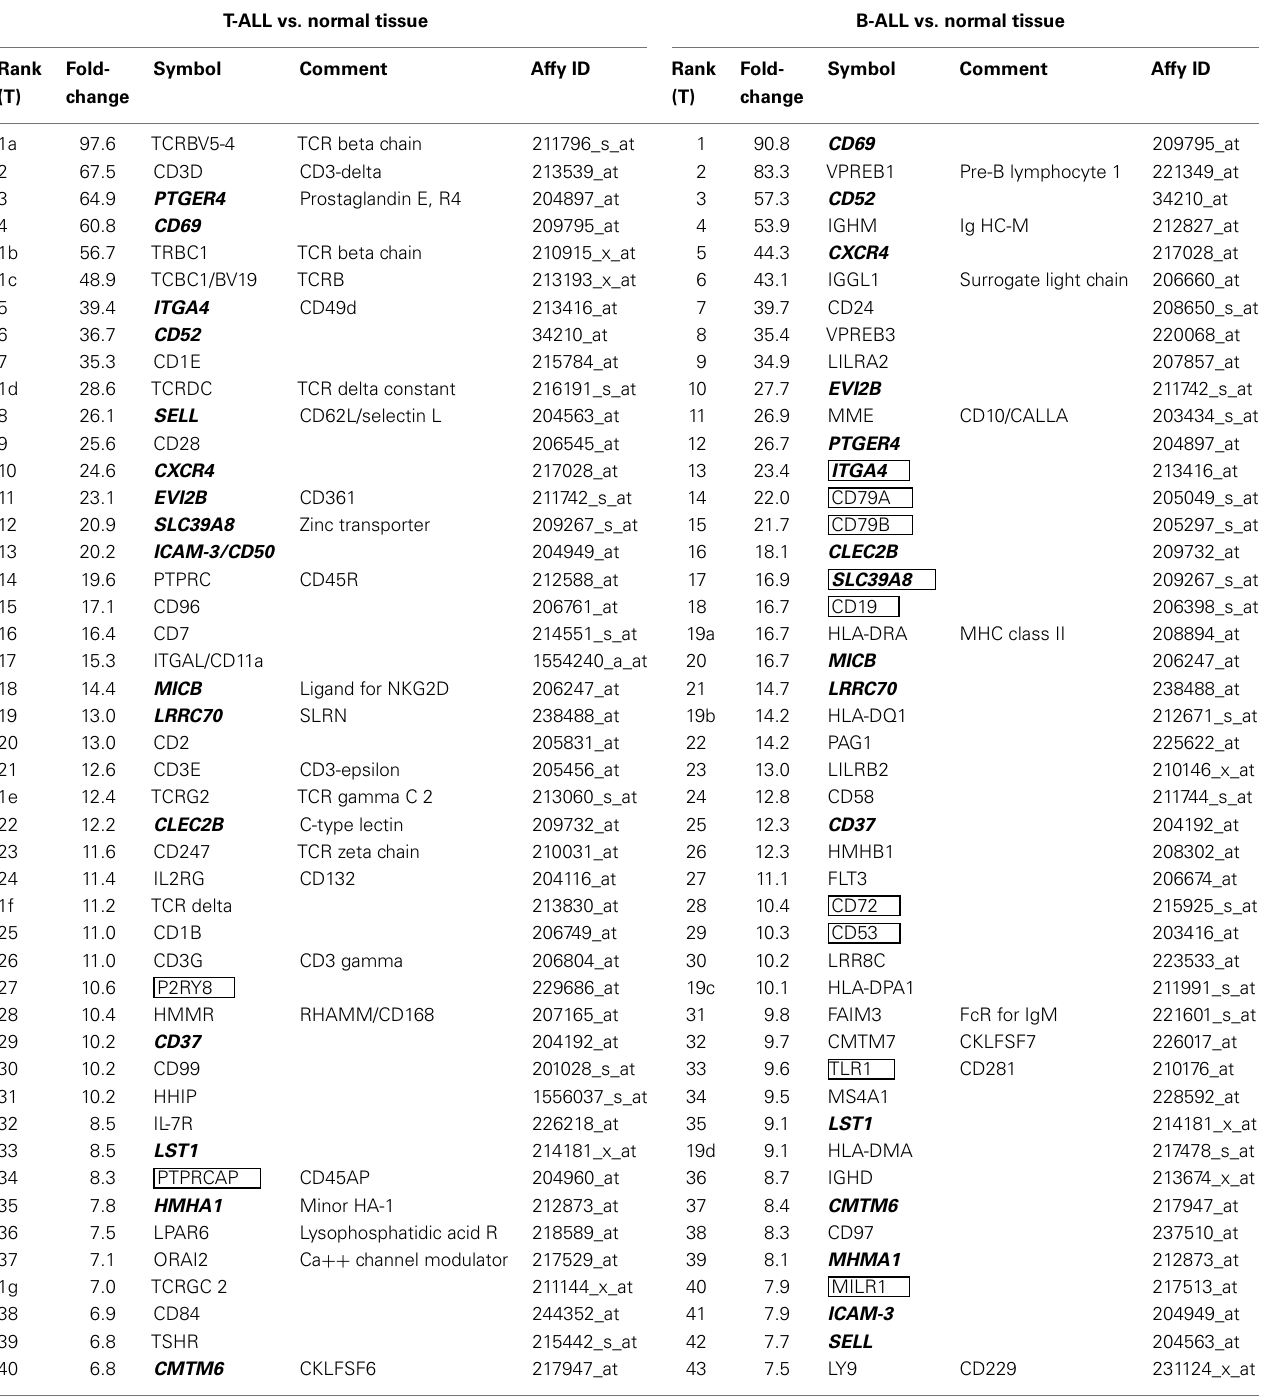
Table 2 |T-ALL and B-ALL cell surface immunotherapy targets . T-ALL vs. normal tissue B-ALL vs. normal